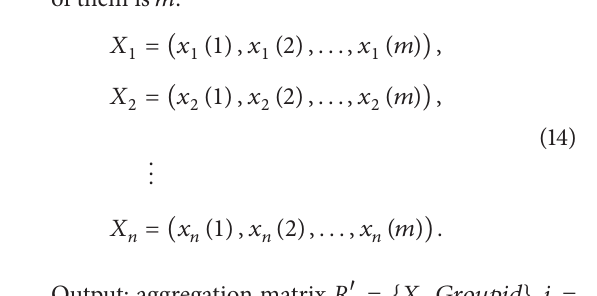
Algorithm 6, multigranularity grey clustering algorithm